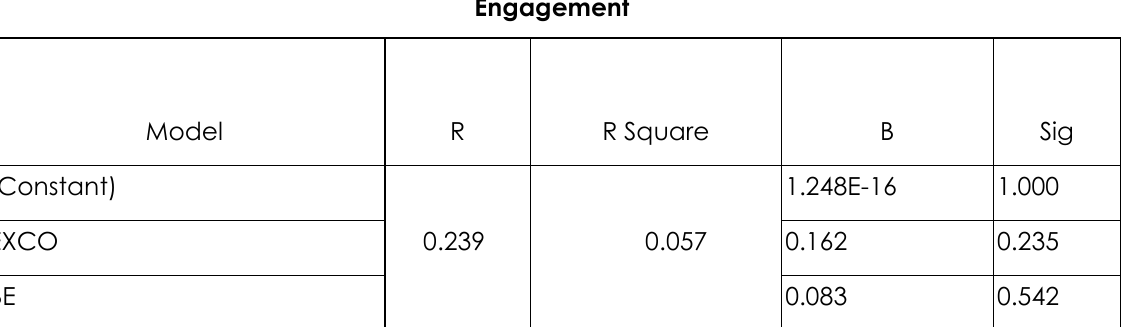
Table 4. SPSS Result of Multiple Regression of Compensation and Benefit to Employee